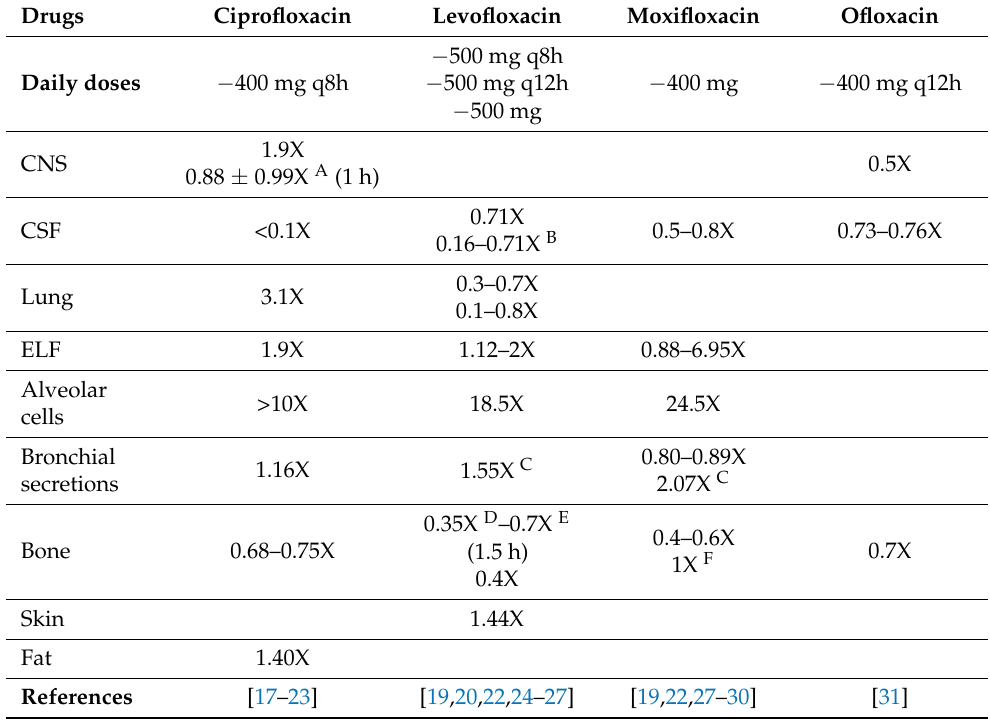
Table 1. Tissue/plasma ratio values for fluoroquinolones. For each drug, the different daily doses that were administered to ICU patients are listed in the